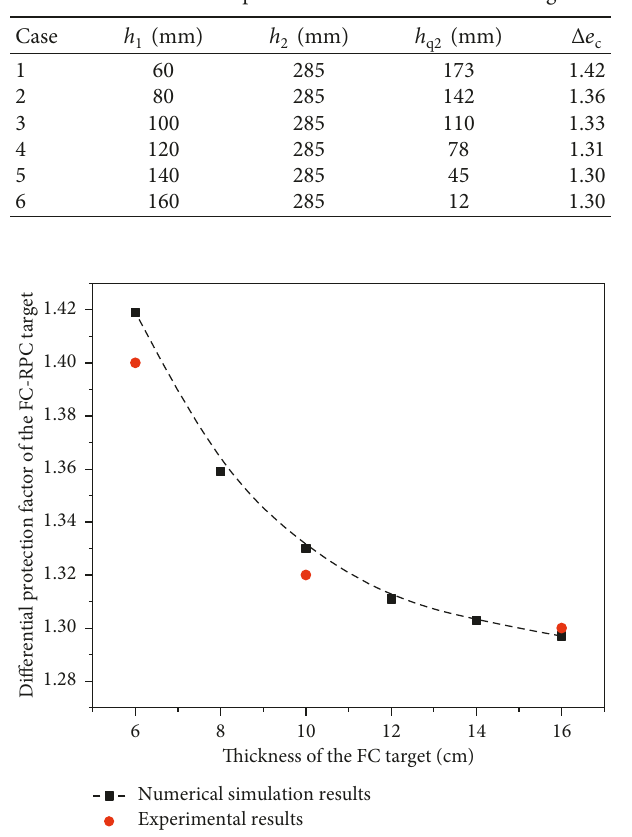
Figure 24: The differential protective factor of the FC-RPC